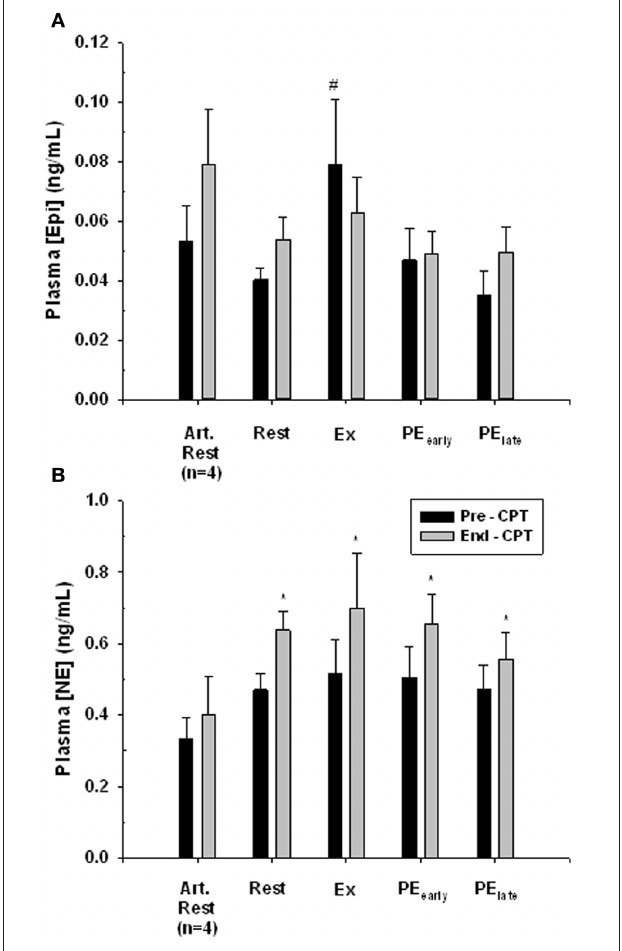
FIGURE 5 | Catecholamine response to CPT in arterialized venous blood at rest (Art. Rest), and deep forearm venous blood at rest, exercise (Ex) early post-exercise (PE early ) and late post-exercise (PE late ). Panel (A) plasma epinephrine concentration. # indicates significantly different from all other Pre-CPT forearm deep venous values, P < 0 . 05. Panel (B) plasma norepinephrine concentration. ∗ indicates End-CPT significantly different from corresponding Pre-CPT, P < 0 . 05.